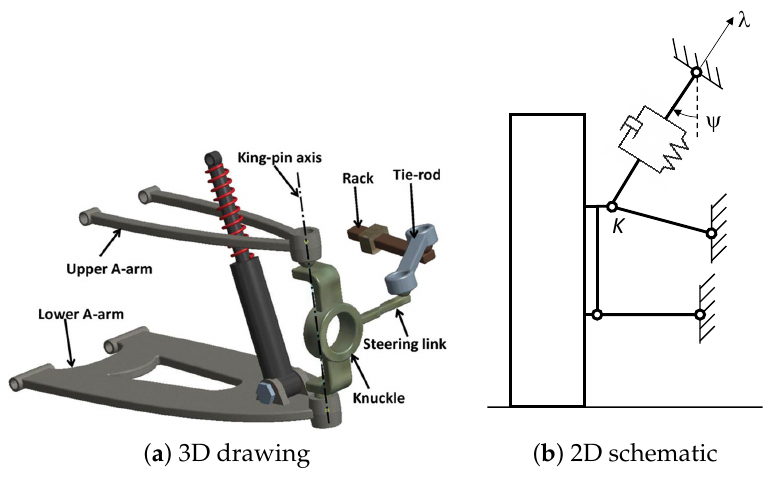
Figure 4. Double wishbone suspension